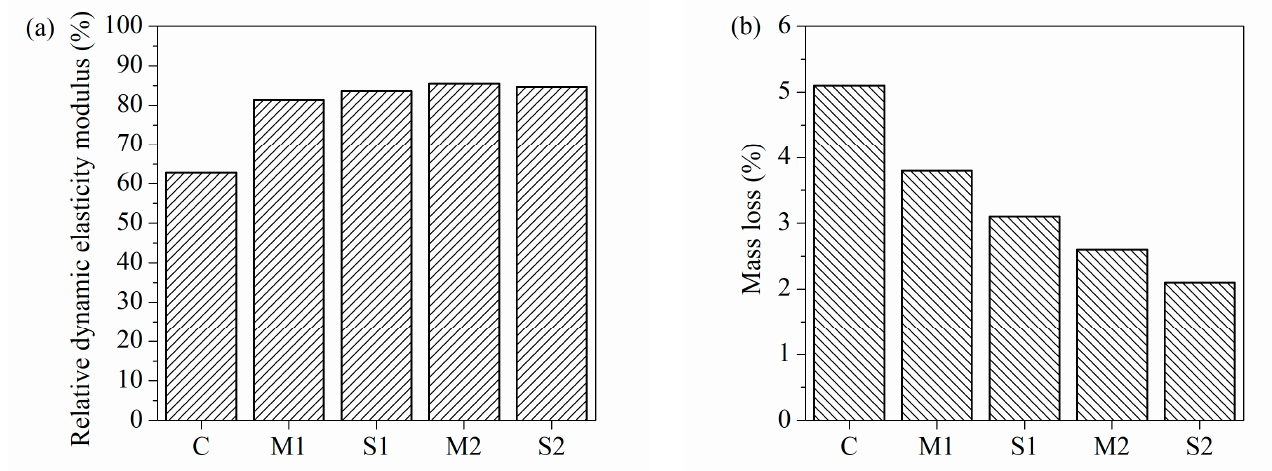
Figure 5. Results of fast freeze-thaw cycle tests of concretes after 300 cycles: ( a ) relative dynamic elasticity modulus; ( b ) mass loss.